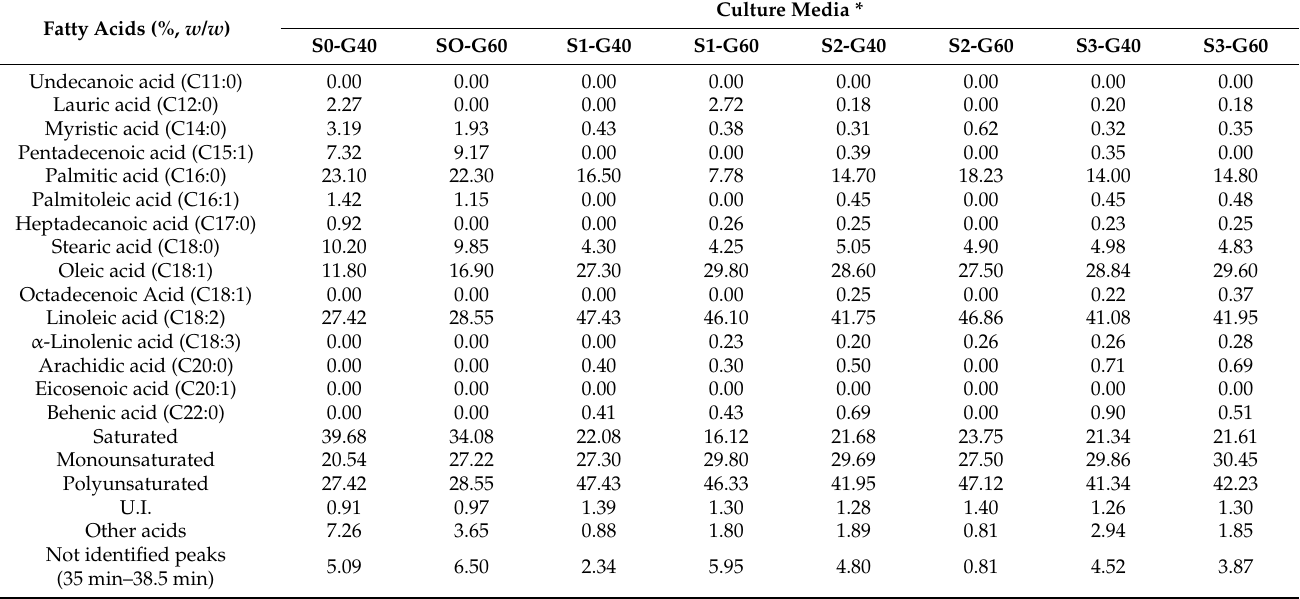
Table 5. FA composition of total lipids synthesized by P. pulmonarius in batch-liquid state fermen- tation cultures, in synthetic media containing 40 and 60 g/L glucose and OMWs with phenolics concentration adjusted to 1, 2 and 3 g/L for 43 days at 26 ± 1 ◦ C. Each point is the mean value of two independent